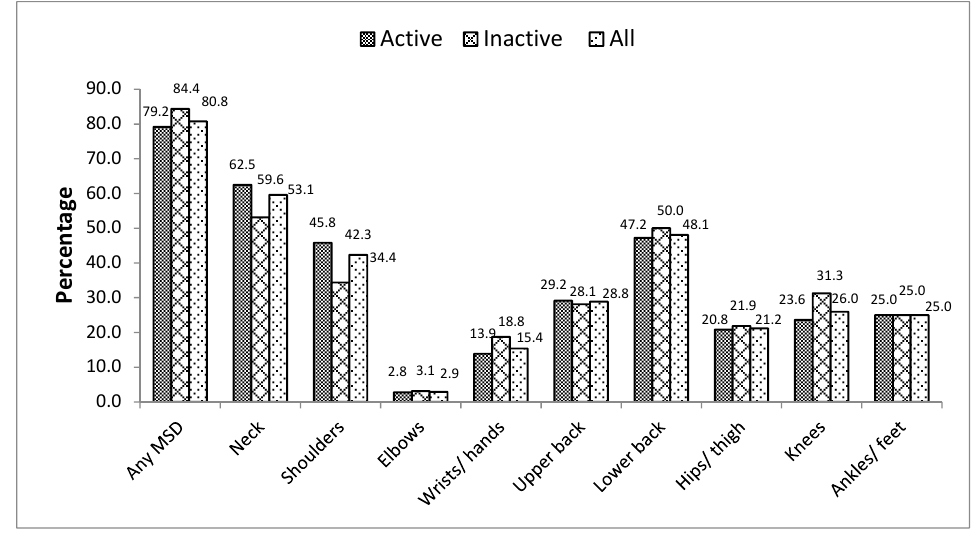
Figure 2. Distribution of MSDs during previous 12 months according to physical activity.